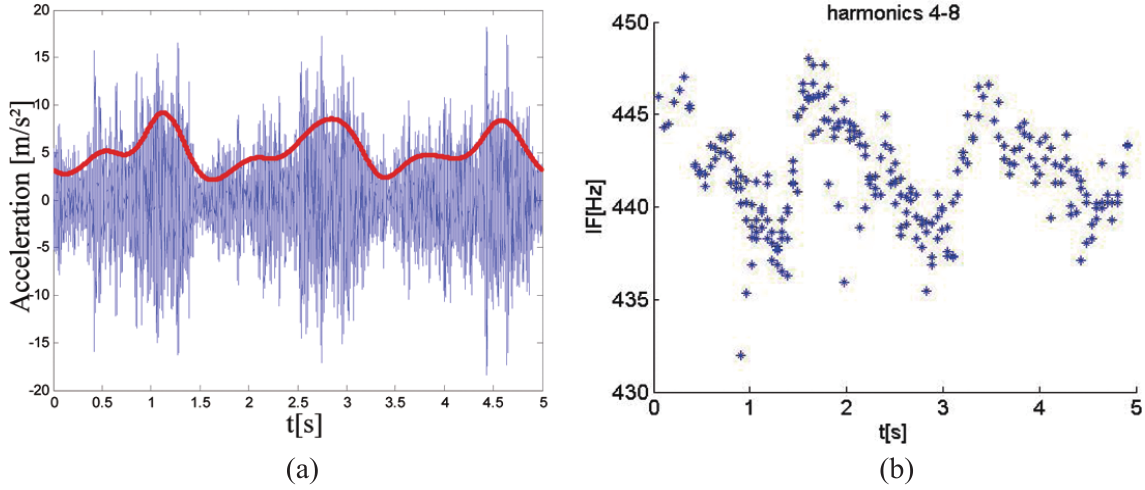
Fig. 17. Example of load dependent vibration signal: a) cyclic variation of one of mesh harmonic (raw vibration band pass fi ltered around ith mesh), b) estimated instantaneous mesh frequency pro fi le (results of normalised frequencies for harmonics no 4–8).